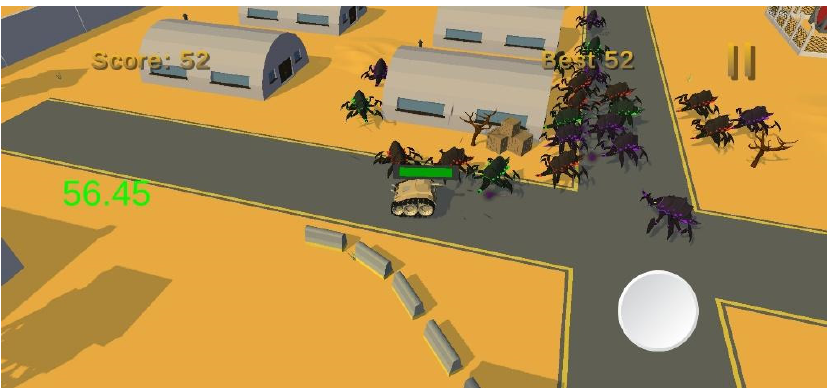
20 Figure 14. Beginning of the optimized version of the game. In general, for the specific version the FPS value ranged between 50 and 60, regardless of the number of enemies and the various actions that can reduce performance on a system. Those actions are a high number of collisions between colliders, continuous creation and destruction of game objects, etc. As shown in Figure